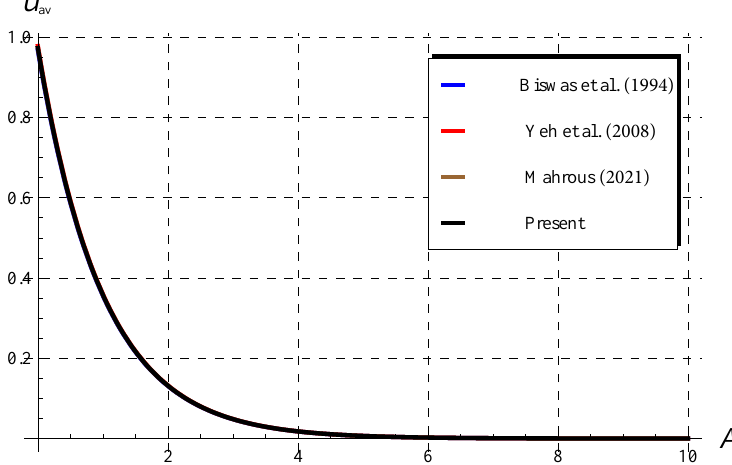
Figure 7. Comparisons between the present cup-mixing average concentration u av and the corre- sponding ones in literature as α → 1 when A 0 = 1.4 and A 2 = 0.01 [4–6].